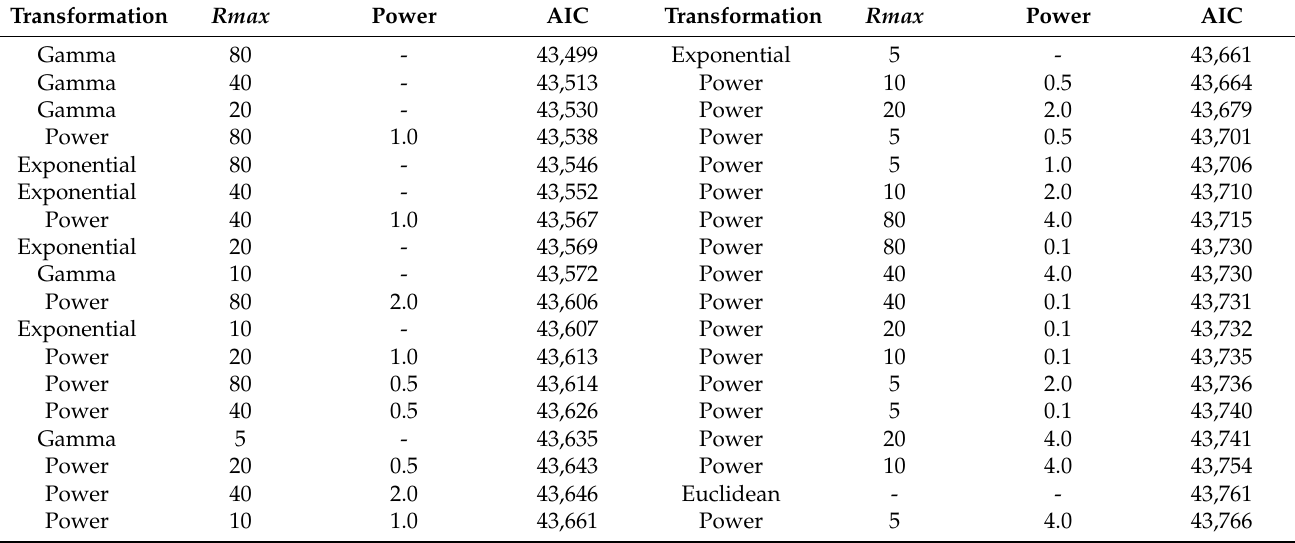
Table 2. Correlation between least-cost path landscape distance with genetic distance measured by the AIC. The resistance raster models are indicated with the transformation, maximum resistance, and power applied to the